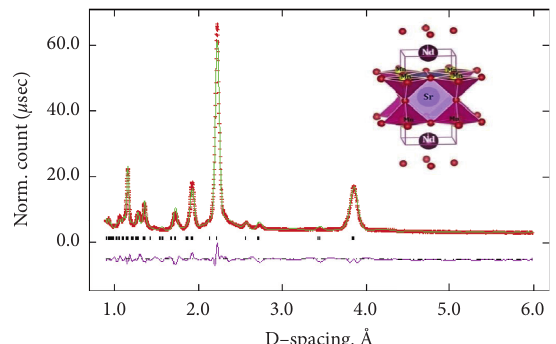
Figure 2: Rietveld refinement profile of NdSrMn 2 O 5+ δ at room temperature with 3D polyhedral representation. The red line depicts the original data, the continuous green line depicts the calculated profile data, and the purple bottom line depicts the difference.